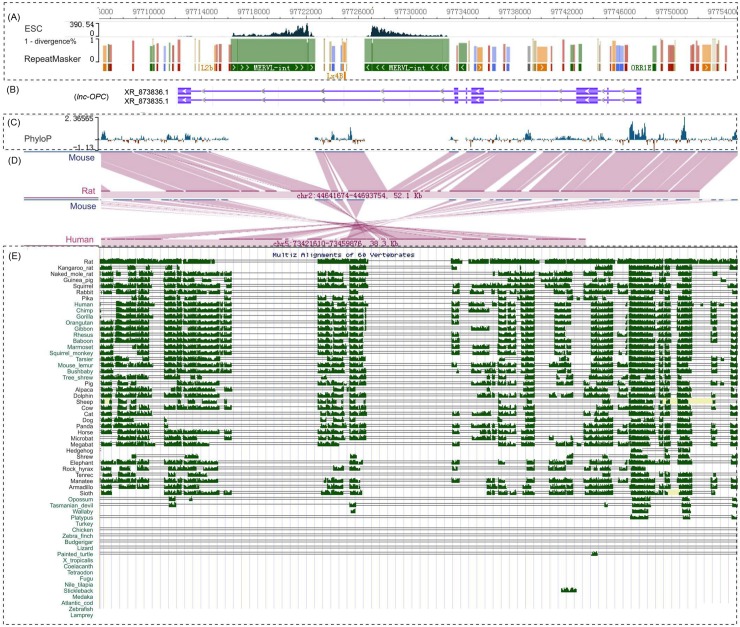
Comparative genomics analysis of lnc-OPC revealed its evolutionary history.(A) Signal tracks of the expression of two TEs at the lnc-OPC locus in ESCs. RepeatMask annotation (bottom) shows two MERVL located in the last intron of lnc-OPC. The height of the bar above the repeat elements corresponds to (1 –%divergence). (B) The structure of lnc-OPC is shown. (C) Conservation displayed as Phylip score. (D) Pairwise alignments of mouse-rat and mouse-human lnc-OPC. (E) Multiple alignments of conservation of lnc-OPC in 60 vertebrates shown in the UCSC browser.